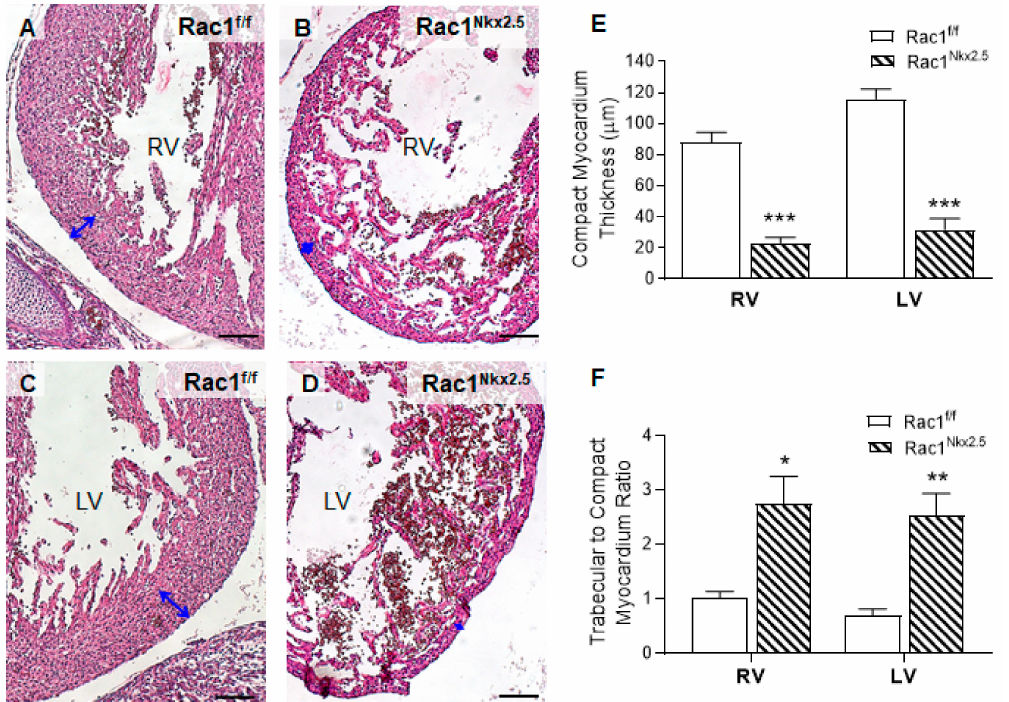
Figure 4. Ventricular myocardium abnormalities in Rac1 Nkx2.5 hearts at E15.5. In comparison to Rac1 f/f controls ( A , C ), the Rac1 Nkx2.5 mice ( B , D ) show thin compact myocardium and hypertrabeculation in the RV and LV wall. The thickness of the compact myocardium in Rac1 Nkx2.5 hearts ( n = 5) was decreased while trabecular to compact myocardium ratio was increased as compared to littermate controls ( n = 6) ( E , F ). Double-headed arrows in ( A – D ) indicate measurements of compact myocardium thickness. * p < 0.05, ** p < 0.01, *** p < 0.001 vs. Rac1 f/f by Student’s t -test. Scale bars: 100 µ